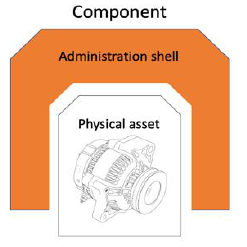
Figure 9. Horizontal and vertical components integration.